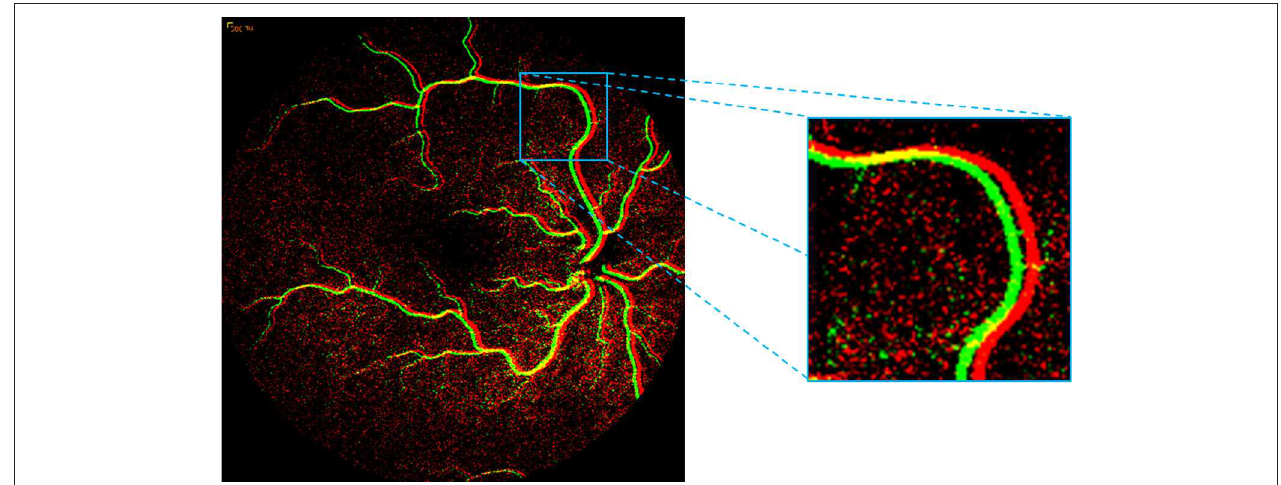
FIGURE 4 | Presence of motion highlighted within the square region by overlaying two successive FA frames. The high-level of noise can be seen in red and green dots in non-vessel image